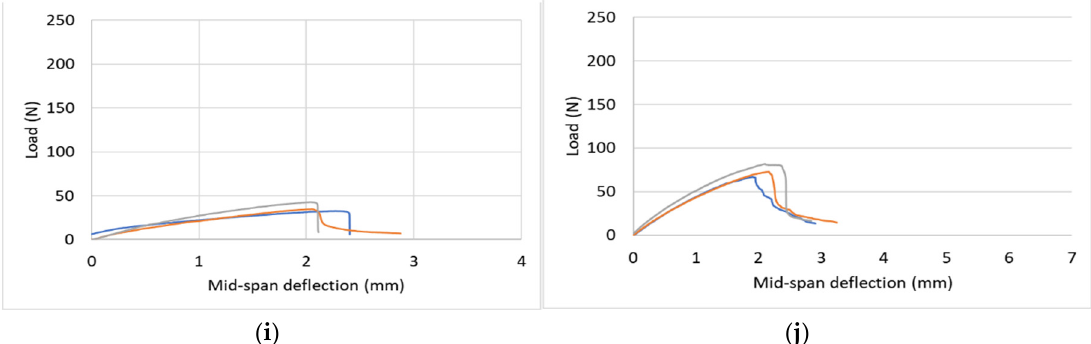
Figure 8. Flexural load vs. midspan de fl ection ( a ) UGC at ambient temperature (28 °C) ( b ) RGC at ambient temperature (28 °C) ( c ) UGC at 200 °C ( d ) RGC at 200 °C ( e ) UGC at 400 °C ( f ) RGC at 400 °C ( g ) UGC at 600 °C ( h ) RGC at 600 °C ( i ) UGC at 800 °C ( j ) RGC at 800 °C.